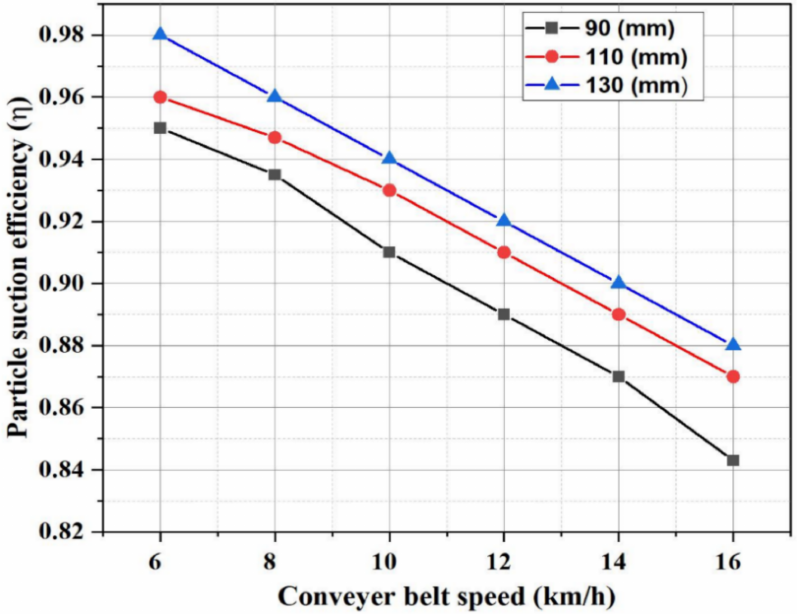
Figure 10. The experimental result of the effect of change of suction port tube diameter on the efficiency of suction of